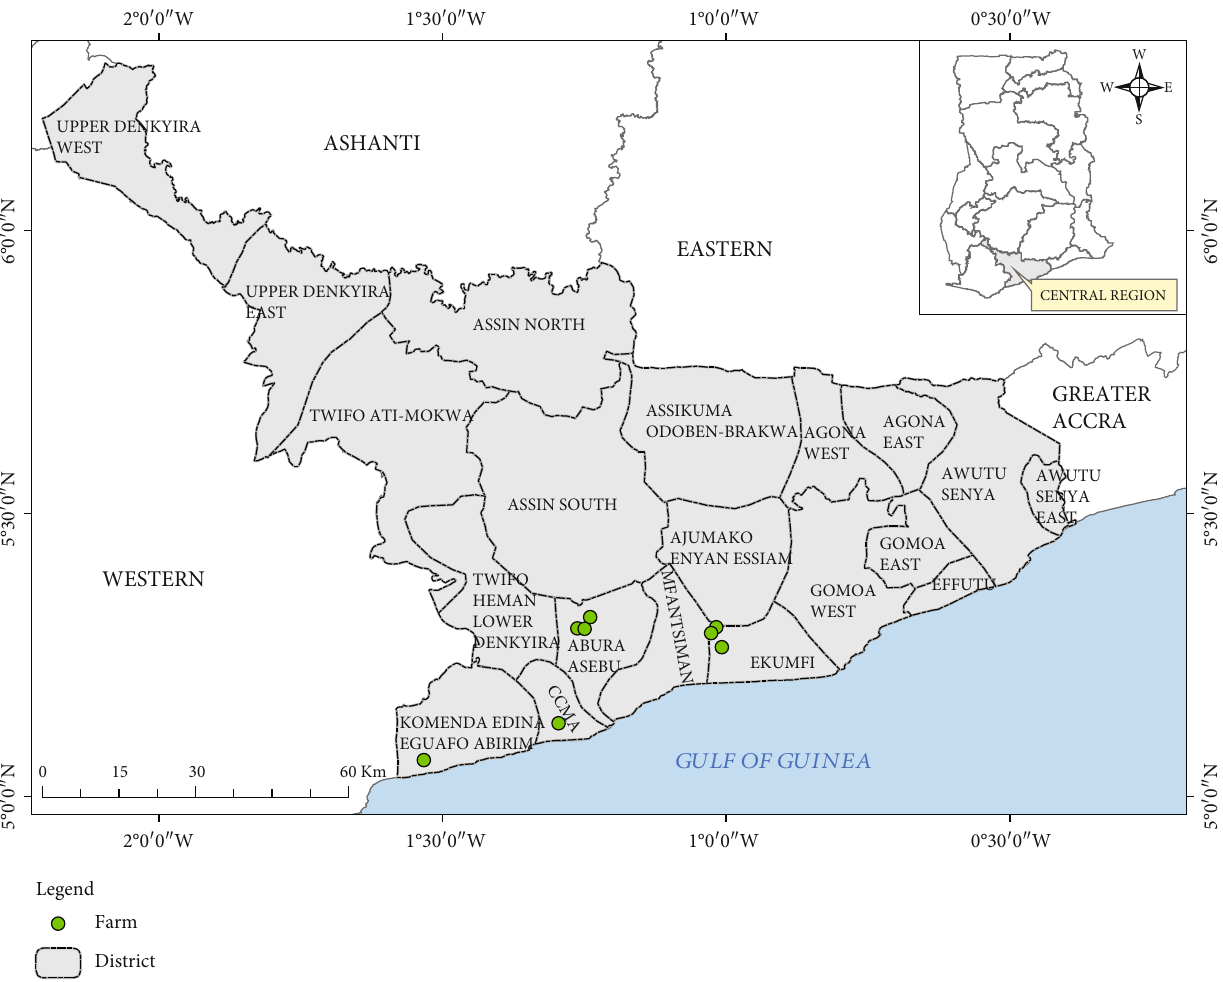
Figure 1: Map of the Central Region showing farm locations and districts where study samples were collected. Credit: Mr. Richard Adade, GIS and Remote Sensing Unit, Centre for Coastal Management, University of Cape Coast,